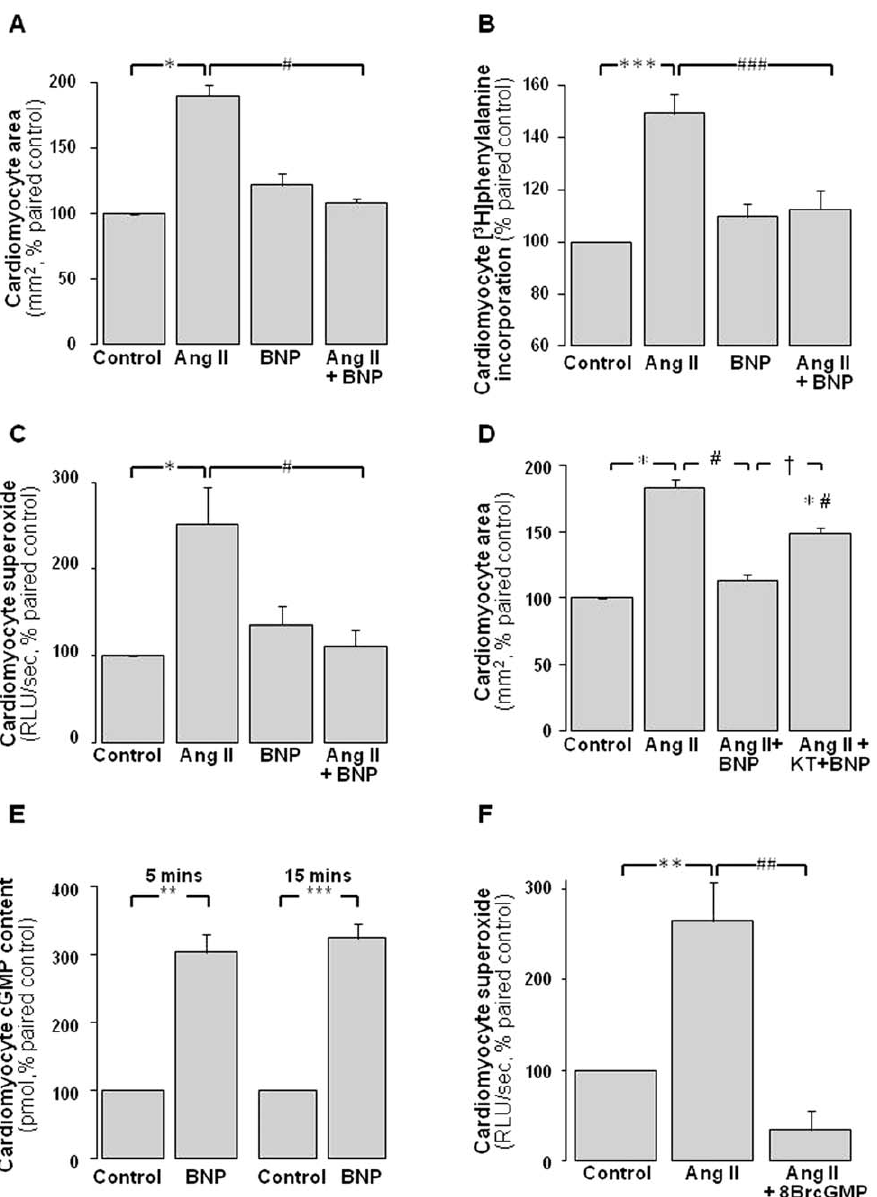
Figure 6. BNP mimics the antihypertrophic and cGMP-dependent cardiomyocyte effects of Angeli’s salt. BNP (1 m mol/L, over 48 h) prevents Ang II (1 m mol/L)-stimulated cardiomyocyte hypertrophy. This is evident on both A cell size (n=11 myocyte preparations); and B de novo protein synthesis (n=9 myocyte preparations, P , 0.001); in addition to C cardiomyocyte superoxide generation (n=11 myocyte preparations). D These antihypertrophic actions of BNP are blocked by the cGK-I inhibitor KT5823 (KT, 250 nmol/L, n=6 myocyte preparations). E BNP acutely stimulates cardiomyocyte cGMP accumulation, over 5 min and 15 min (both n=5 myocyte preparations). F Furthermore, 8BrcGMP (1 mmol/L, n=4) also mimics the ROS-suppressing actions of both AS and BNP. *P , 0.05, **P , 0.01 and ***P , 0.001 vs control; # P , 0.05, ## P , 0.01 and ### P , 0.001 vs Ang II alone, { P , 0.05 vs Ang II + BNP.